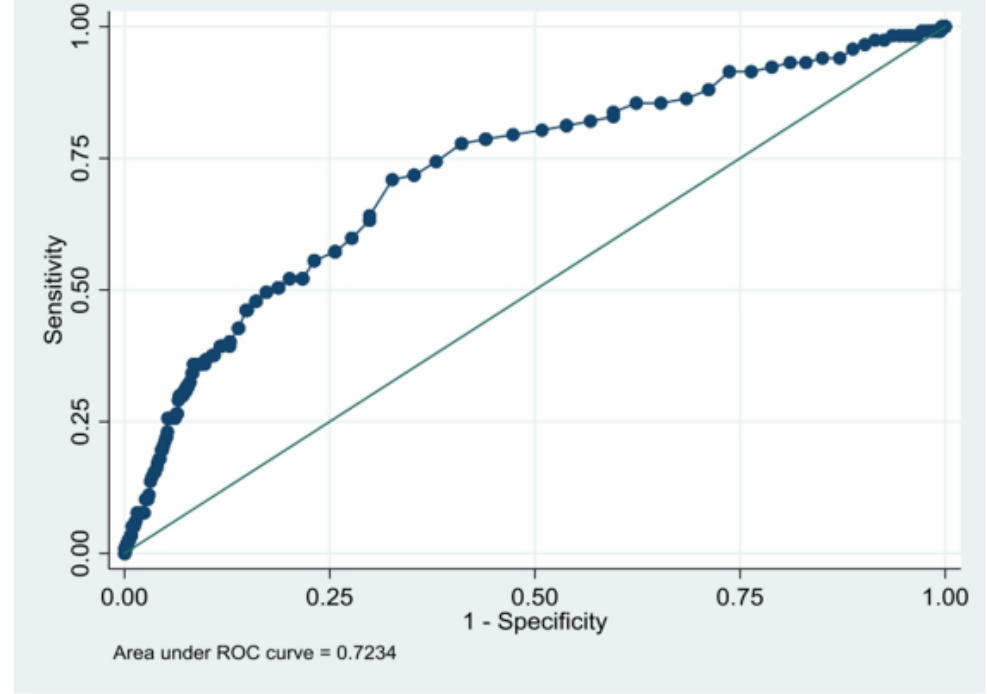
Figure 4. ROC curve for the identification of patients with in-hospital bleeding in the validation data set. ROC: receiver operating characteristic.